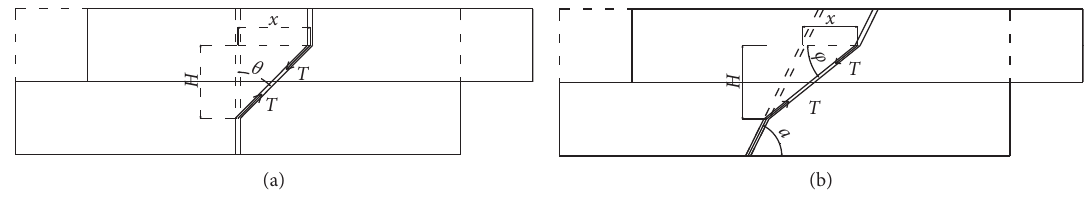
Figure 1: Root deformation diagram: (a) the root is orthogonal to the shear plane; (b) the root intersects the shear plane